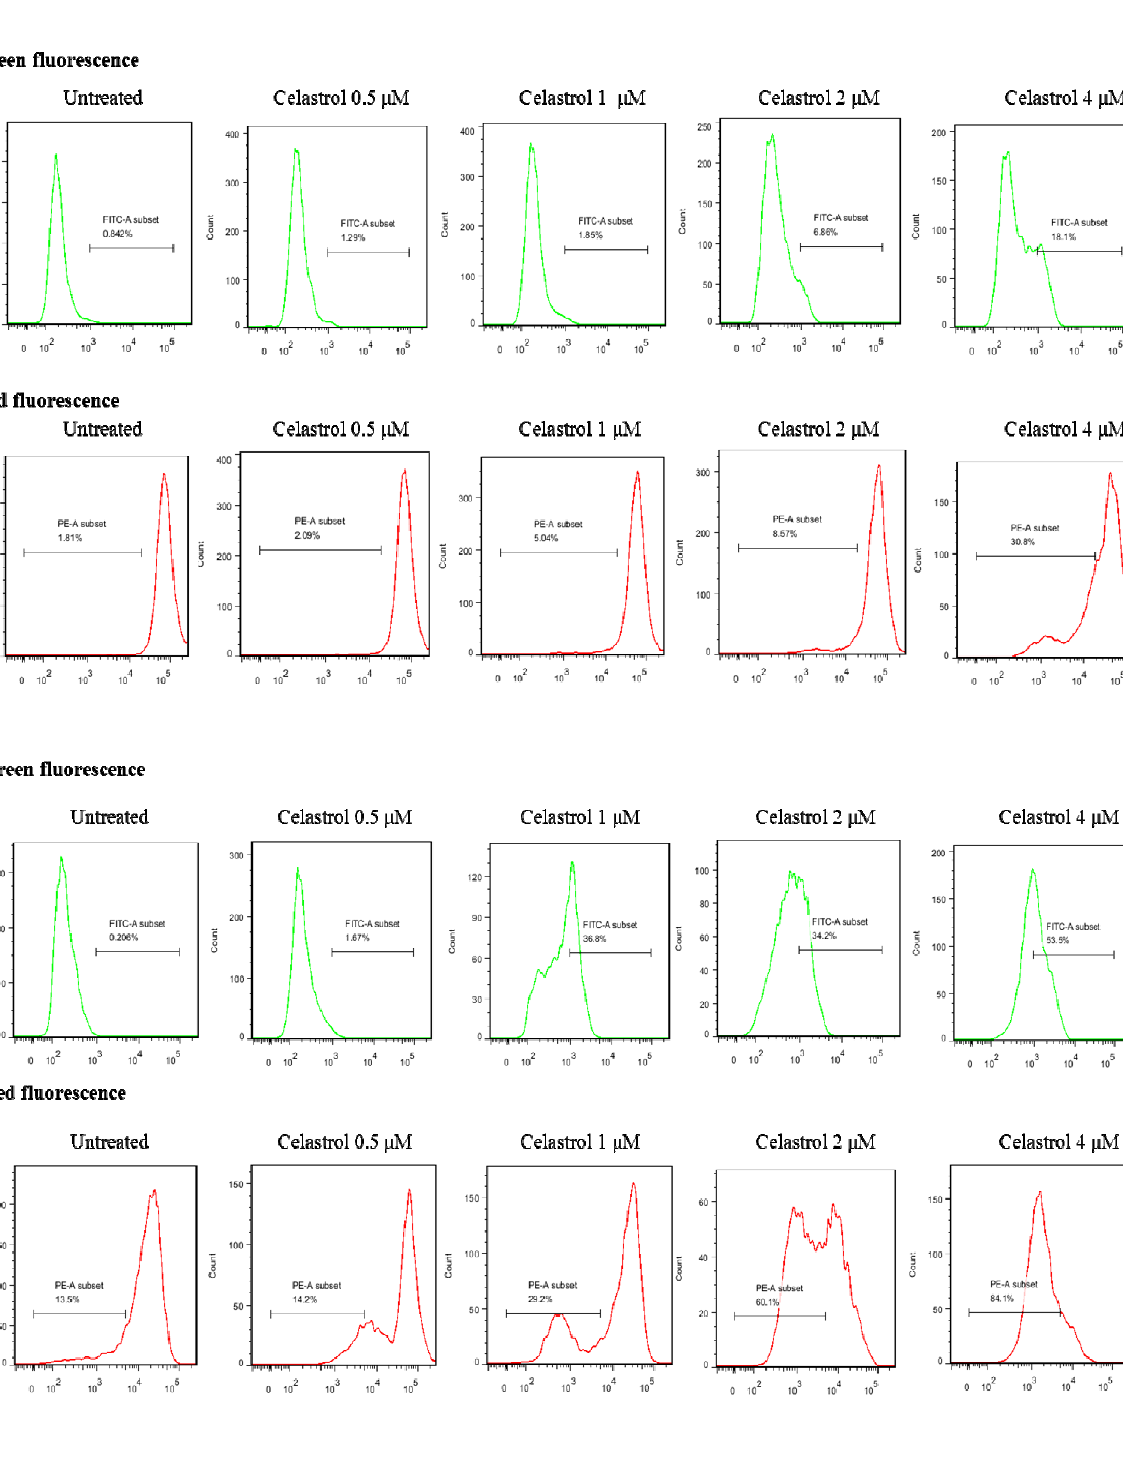
Figure 3. Celastrol induces apoptosis via mitochondria-dependent pathway. ( A ) The level of MMP of H1650 cells was analyzed after the treatment of celastrol for 6 h by flow cytometry. ( B ) The level of MMP of H1650 cells was analyzed after the treatment of celastrol for 24 h by flow cytometry. ( C ) Celastrol regulated the ratio of Bcl-2/Bax and caused cytochrome C release from the